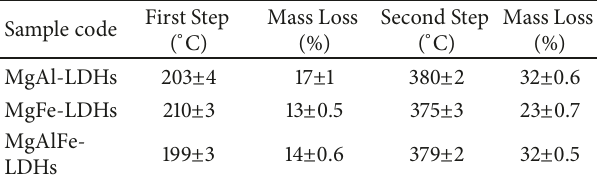
Table 1: Decomposition steps and mass loss from